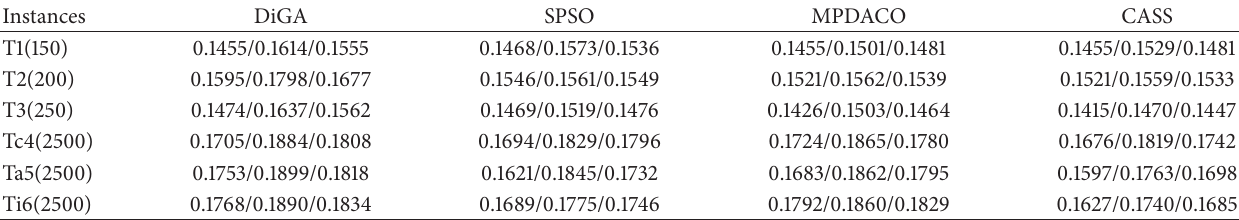
Table 2: The obtained fitness values for the compared algorithms